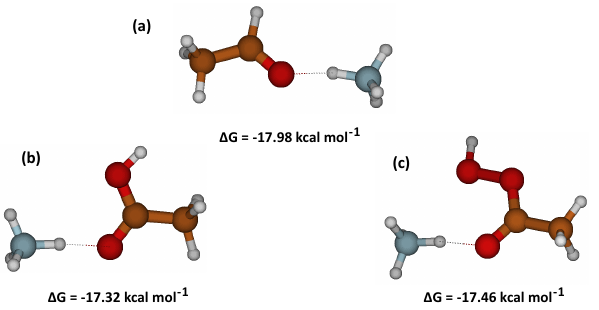
Figure 6. Quantum chemical calculations of the free energy related to the cluster formation between NH + and three structurally sim- 4 ilar molecules with different functional groups: (a) acetaldehyde, (b) acetic acid and (c) peracetic